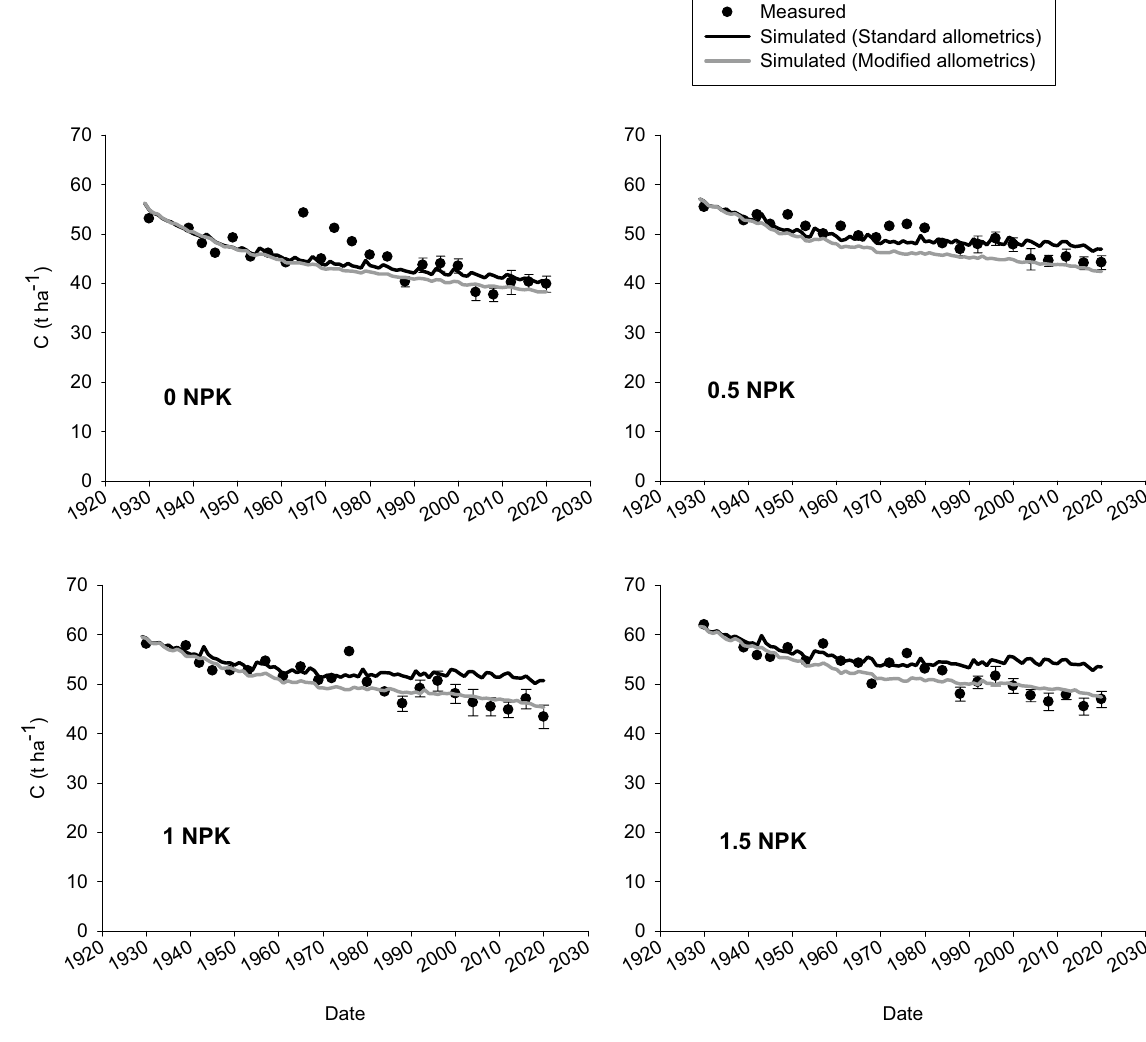
Figure 3. Measured (circles) and simulated (lines) soil C stock (t C ha −1 ) in B2e-field topsoil (0-25 cm) of treatments exposed to 0, 0.5 NPK, 1 NPK, and 1.5 NPK during 1923–2020. Error bars are standard error of the means (SE).